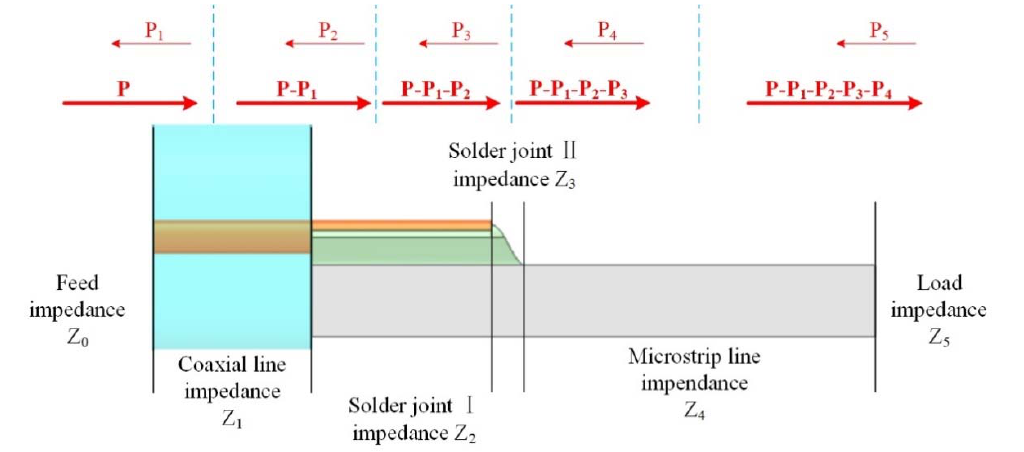
Figure 10. Energy transfer between parts of lead wire interconnection.